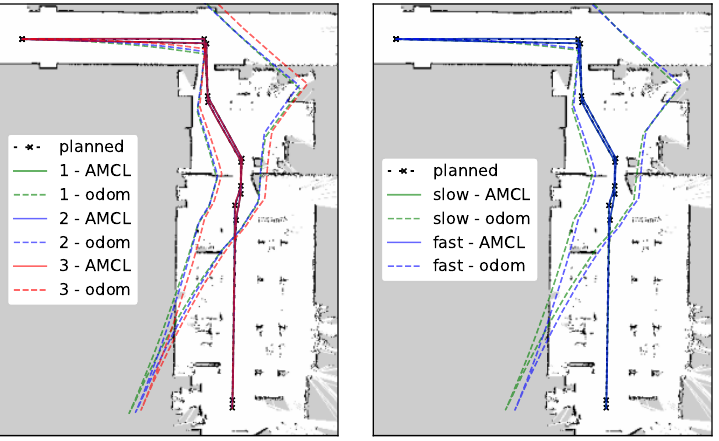
Figure 16. Comparison of planned and travelled paths in a slow and a fast pass—whole path and a zoom-in.